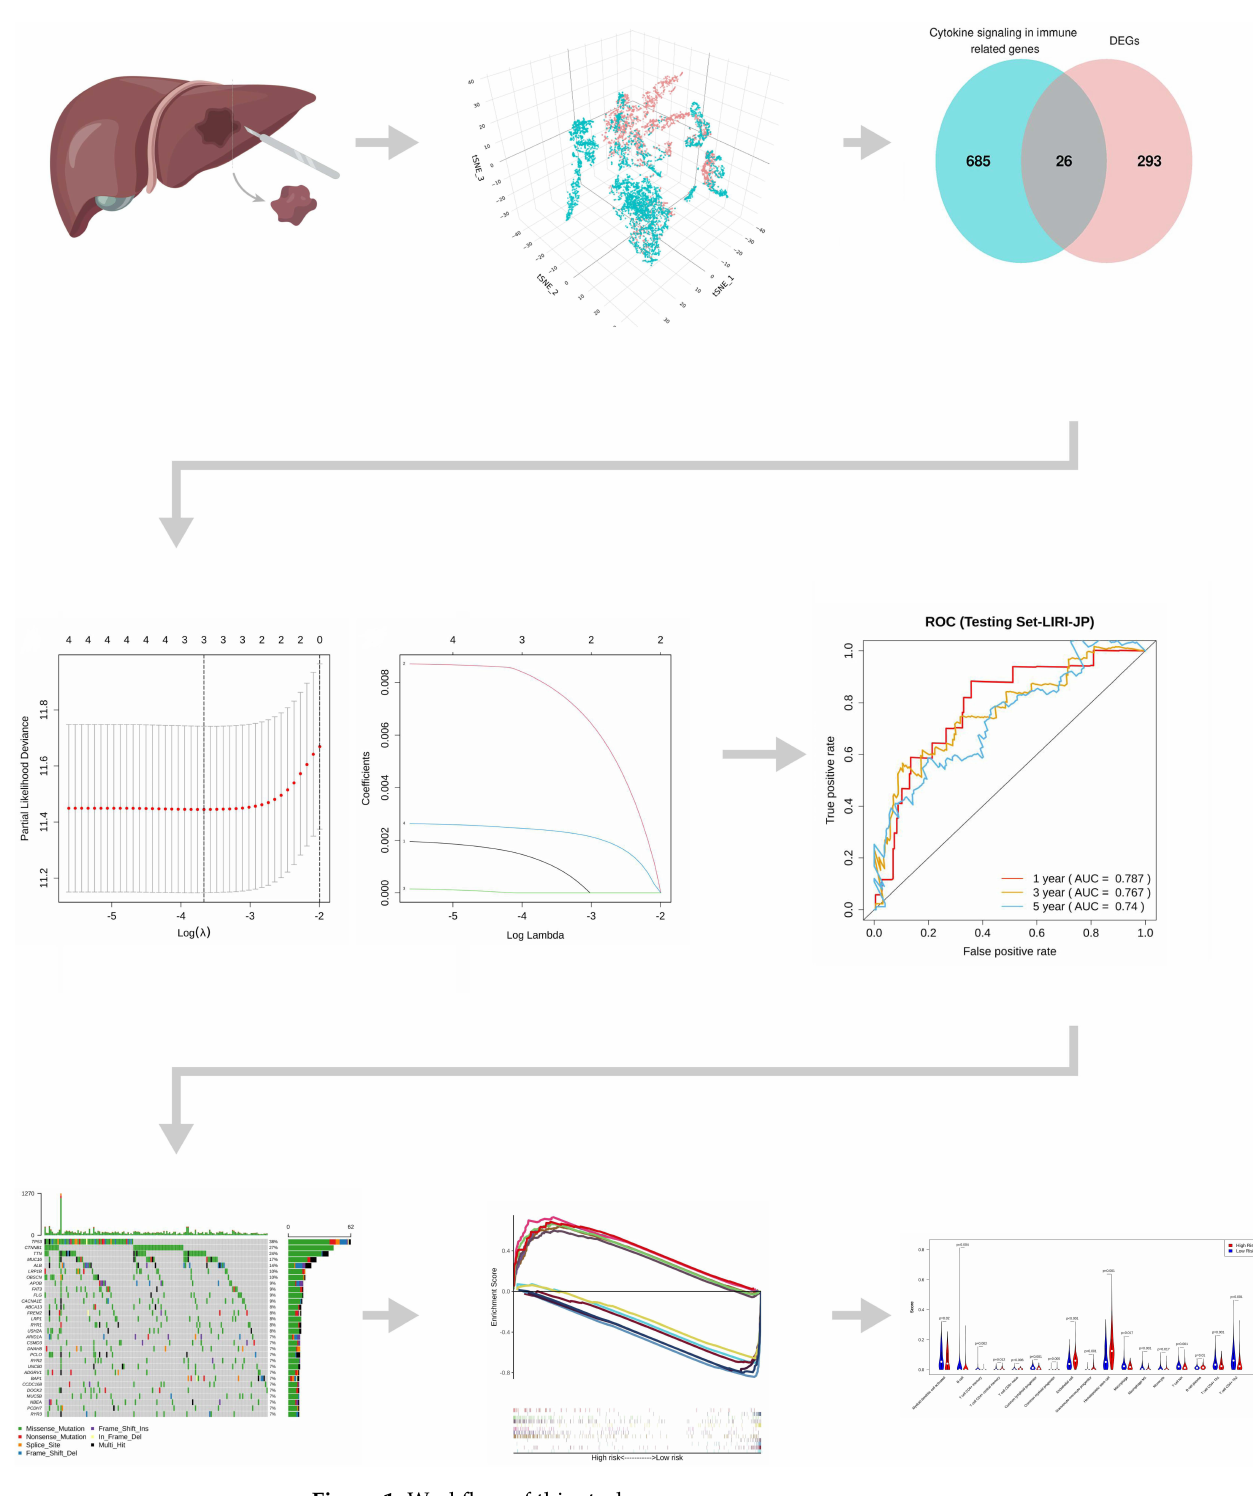
Figure 1. Workflow of this